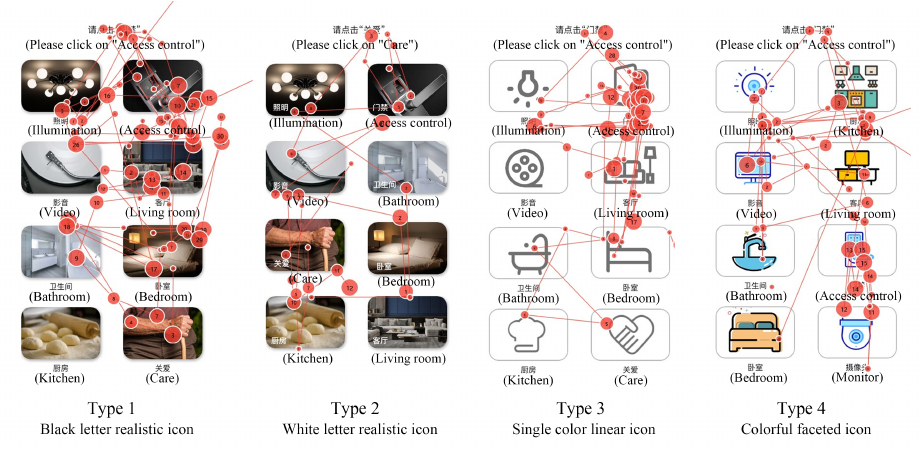
Figure 5. Scanning paths of 4 types of button interfaces.